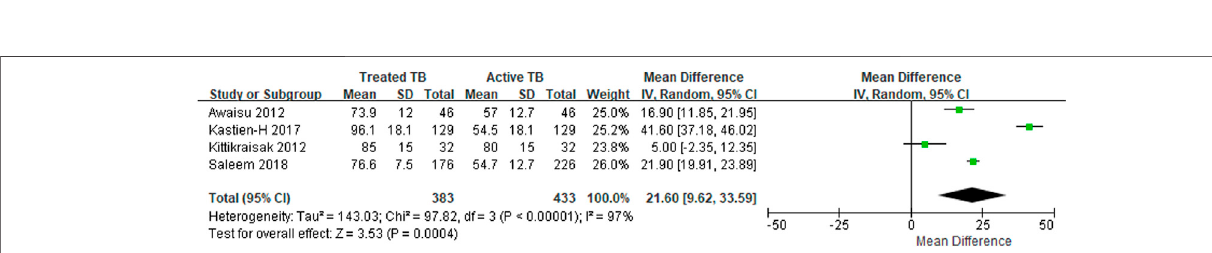
FIGURE 3 | The meta-analysis for the EQ VAS mean differences before and after treatment of tuberculosis .